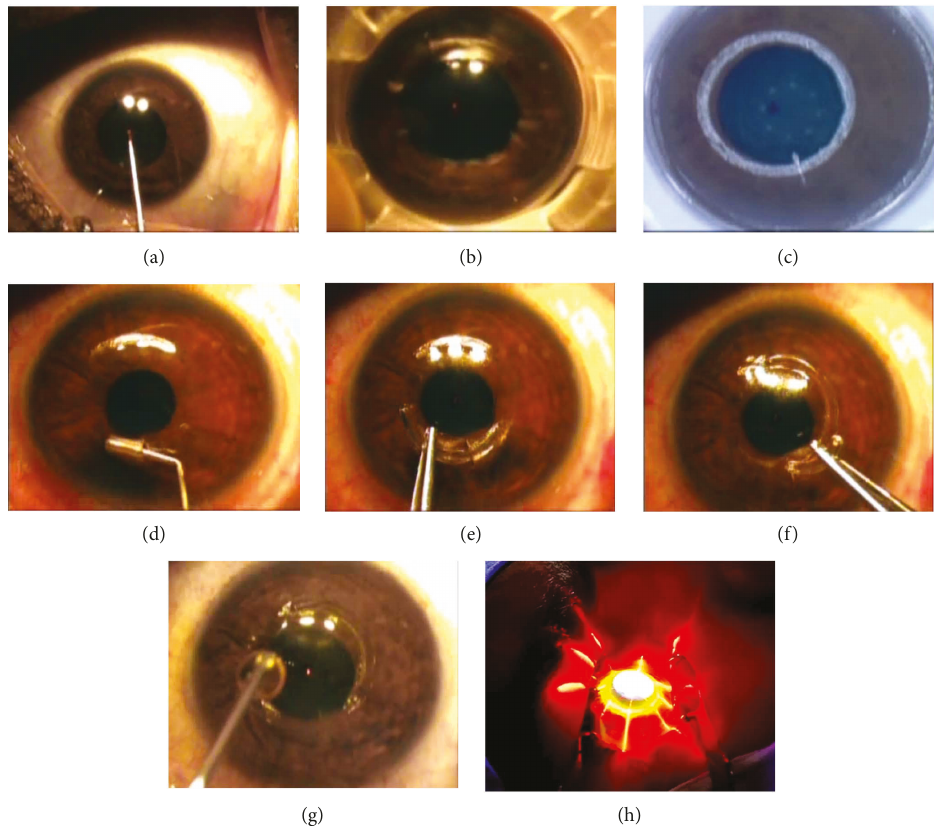
Figure 1: CXL PLUS in the right eye; (a) marking the corneal center when the patient is fi xating at fl ashing light, (b) suction ring application onto the cornea, (c) corneal tunnel creation using the femtosecond laser, (d) checking the patency of the tunnel by passing a spatula through the limbs of the tunnel, (e) implantation of the temporal Keraring segment, (f) implantation of the nasal Keraring segment, (g) ribo fl avin dropping onto the cornea, and (h) accelerated epithelium-on